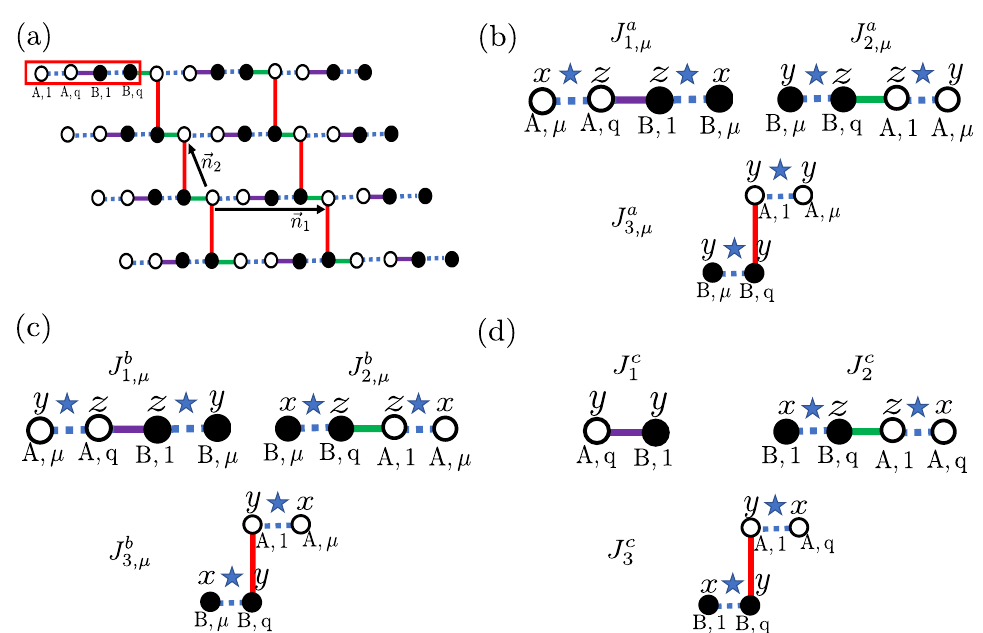
Figure 3: (a) A 2D lattice where the Hamiltonian (7) is defined. Each unit cell consists of 2 q sites and dashed lines represent the abbreviated q − 2 sites between the sites µ = 1 and µ = q . Each unit cell is labeled by ⃗ r = l and ⃗ n are the primitive vectors for the lattice. The sites in a unit cell are divided into 2 two sublattices, A and B. White circles and black circles represent sites in sublattice A and B, respectively. In each set, the index µ ( µ = 1, 2, ..., q ) is used to distinguish different sites. (b), (c) and (d) denotes the terms in H odd Blue stars represent the product of σ z ’s on corresponding abbreviated